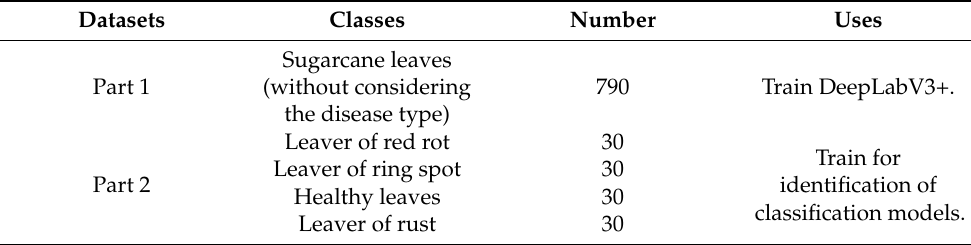
Figure 2. Sample images of the three disease classes and the healthy class: ( a ) red rot, ( b ) ring spot, ( c ) rust, and ( d ) healthy. Table 1. Number and use of datasets.